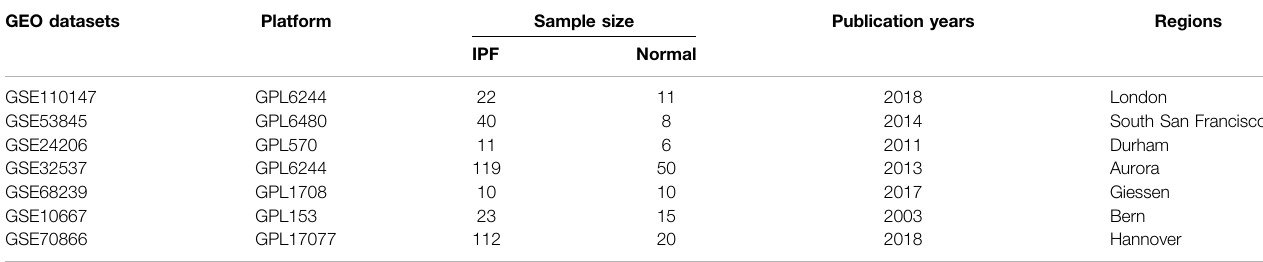
TABLE 1 | The main features of 7 selected datasets included in this analysis. GEO datasets